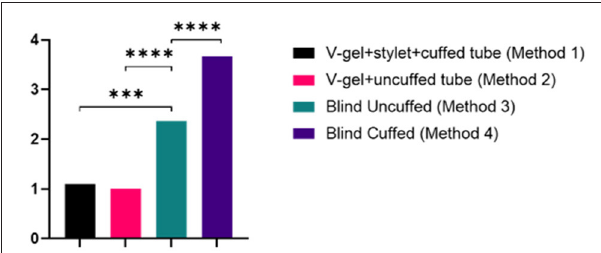
FIGURE 4 | Graph of the number of attempts for each intubation method. Data are presented as mean and statistically significant differences are indicated by lines and